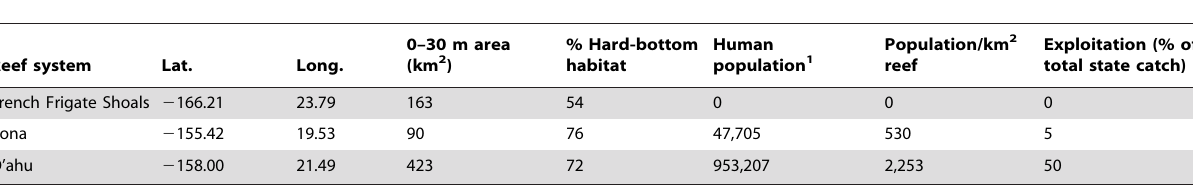
Table 1. Characteristics of the three coral reef areas included in this study.